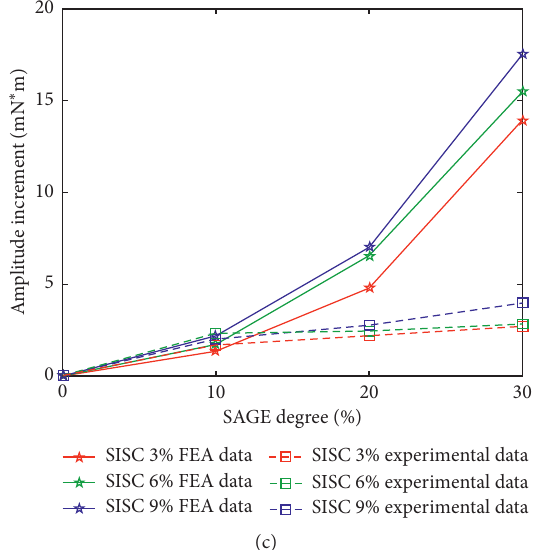
Figure 15: FEA and experiment comparison in CF cases with increased SISC: (a) 2nd harmonic, (b) 4th harmonic, and (c) 6th harmonic.